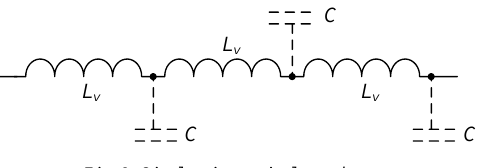
Fig. 3. Single wire equivalent scheme.